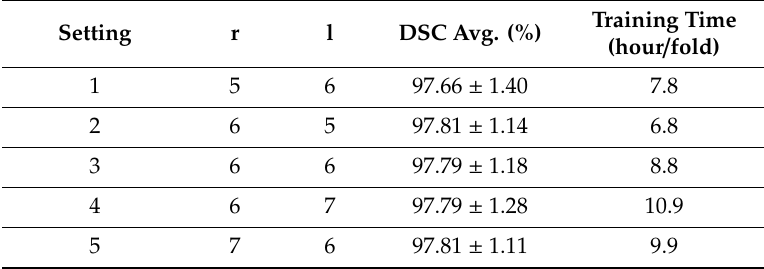
Table A2. DSC (%) of the proposed system with di ff erent settings of growth rate (r) and layer (l) in the dense block. A five-fold cross-validation process was